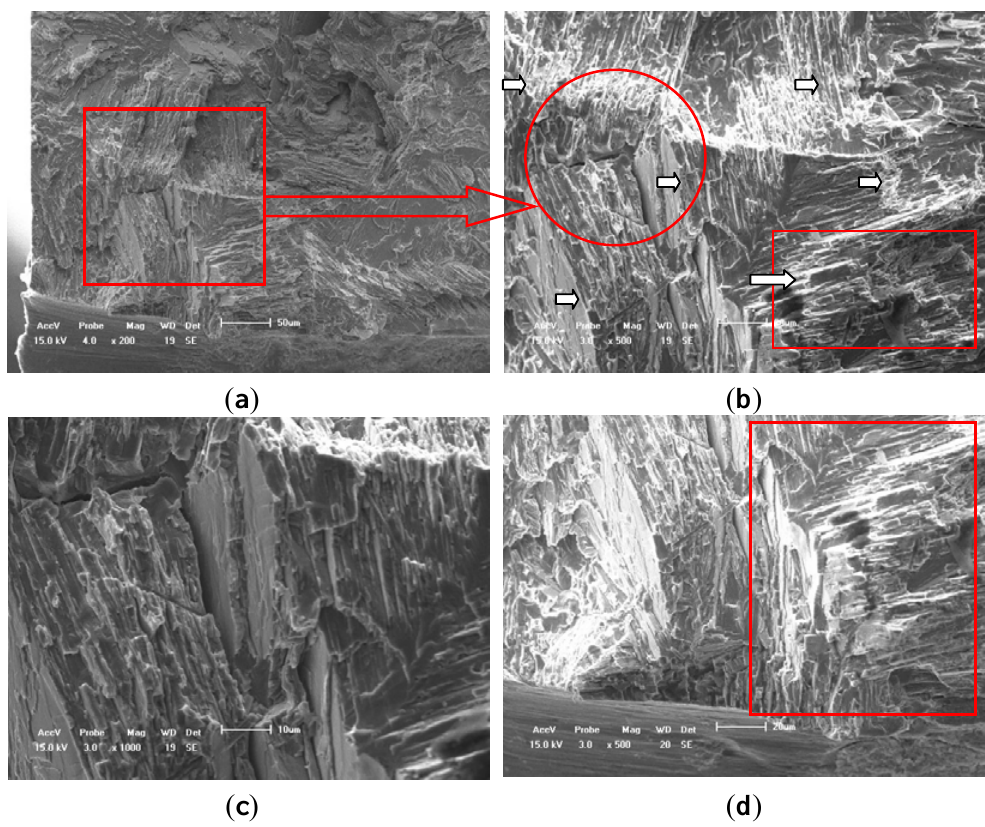
Figure 5. Fatigue fracture characteristics of TiAl alloy with 8% Nb content at room temperature. ( a ) Facet surface, (bar scale 50  m); ( b ) Translamellar and interlamellar decohesions, (bar scale 20  m); ( c ) Translamellar decohesion, (bar scale 10  m); ( d ) Interlamellar decohesion, (bar scale 20 